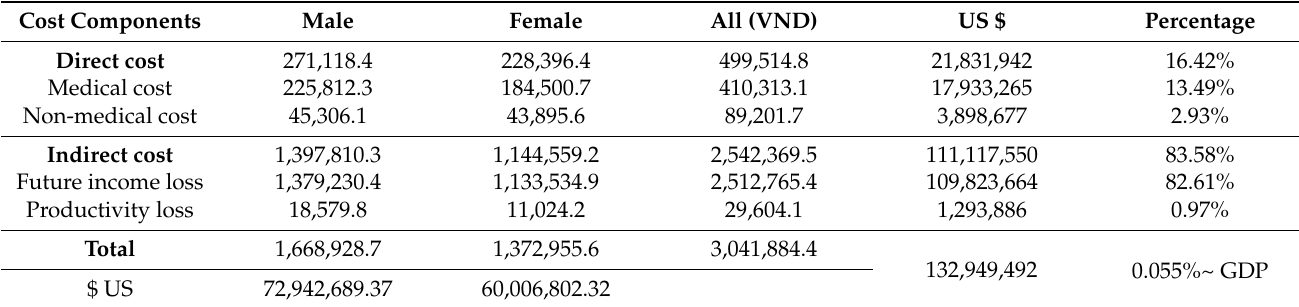
Table 4. Estimated total economic burden of CRC at national level in Vietnam, 2018 (VND million). Cost Components